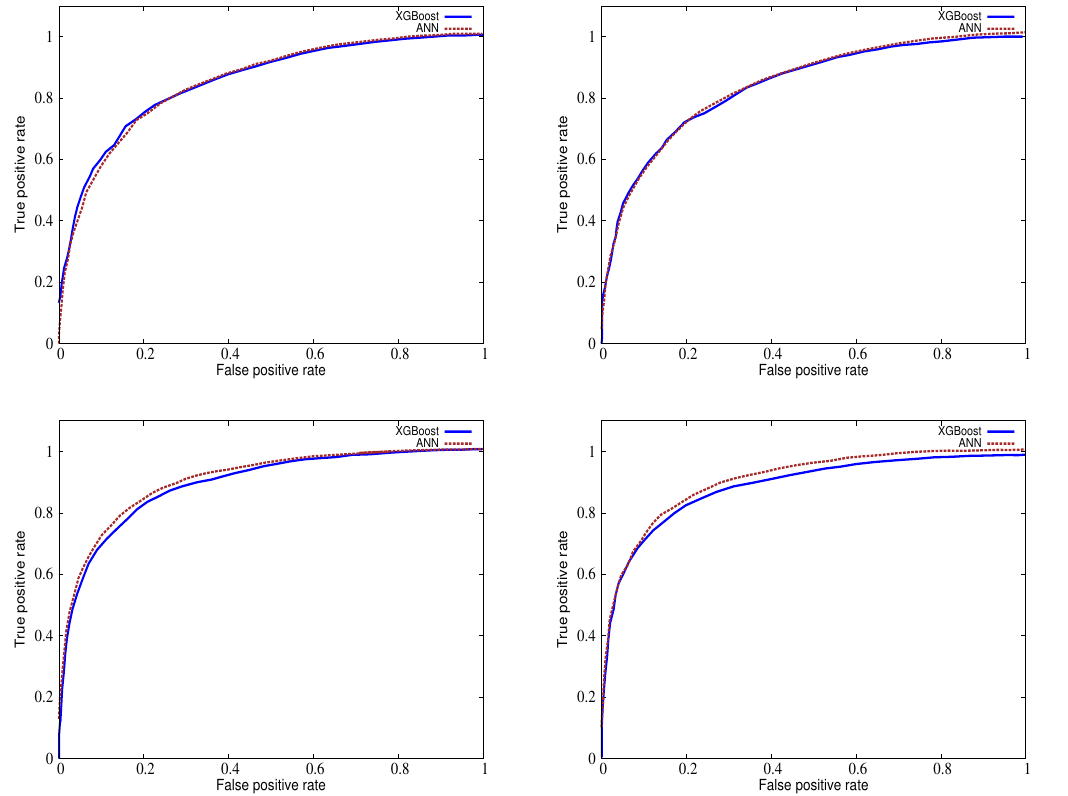
Figure 19 . ROC curves of vector boson fusion channel for Type I BP I (top left), Type I BP II (top right), Type II BP I (bottom left) and Type II BP II (bottom right).